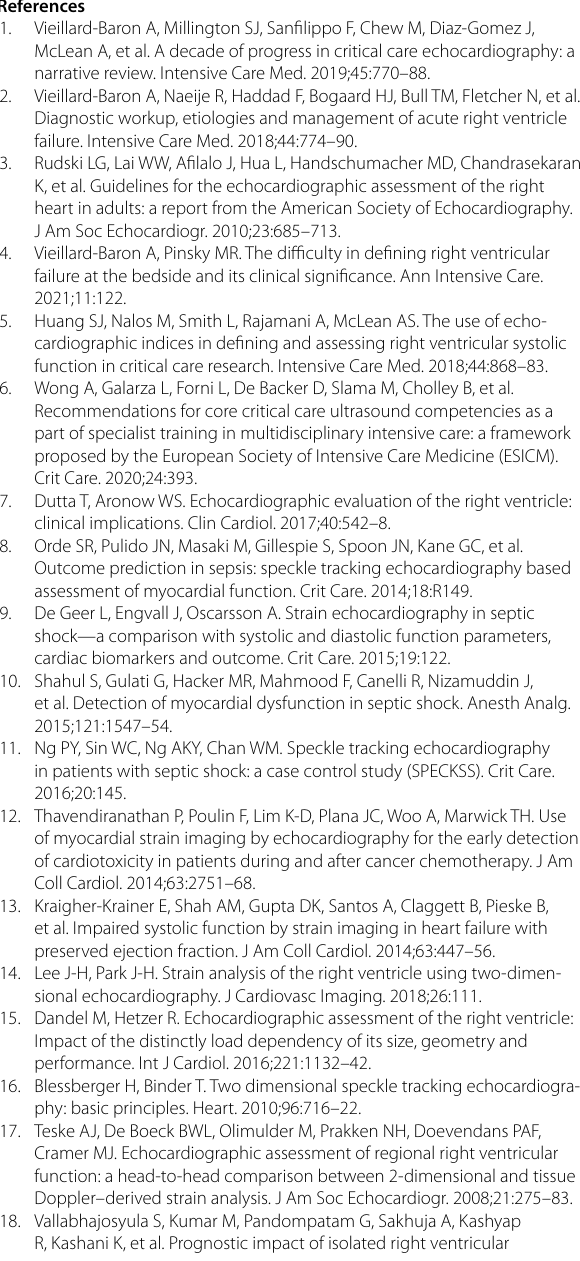
Additional file 1: Table S1. Overview of eligible patients from the SICS cohorts and RV function measurements obtained. Table S2 . Overview of missing strain segments. Table S3. Baseline characteristics based on conventional RV function measurements preserved and strain reduced (CPSR). Table S4. RV echocardiography variables categorized by receiving mechanical ventilation (with peep > 8). Table S5. Baseline characteristics sensitivity analysis: RV fractional area change (FAC) preserved versus RV strain reduced (FPSR). Figure S1. Sensitivity analysis; Venn diagram FAC versus RV Strain indicating RV dysfunction. Section S1. Detailed protocol image acquisition and strain